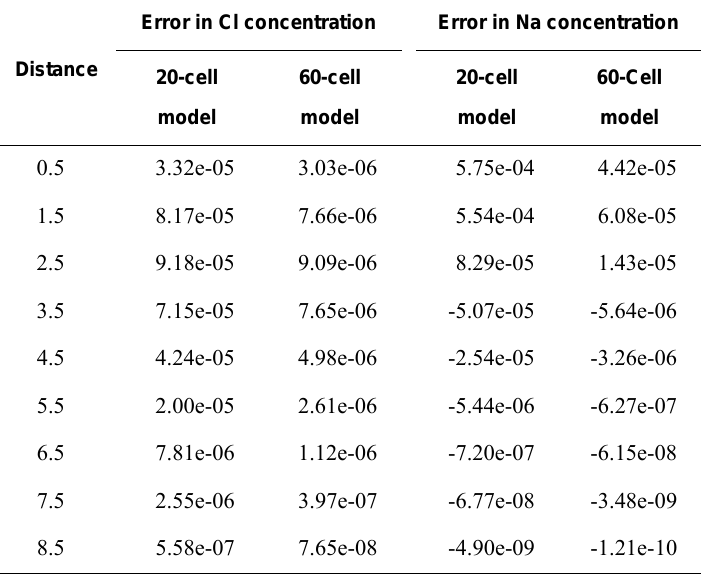
Table 32. Numerical errors relative to the analytical solution for example 12 for a 20-cell and a 60-cell